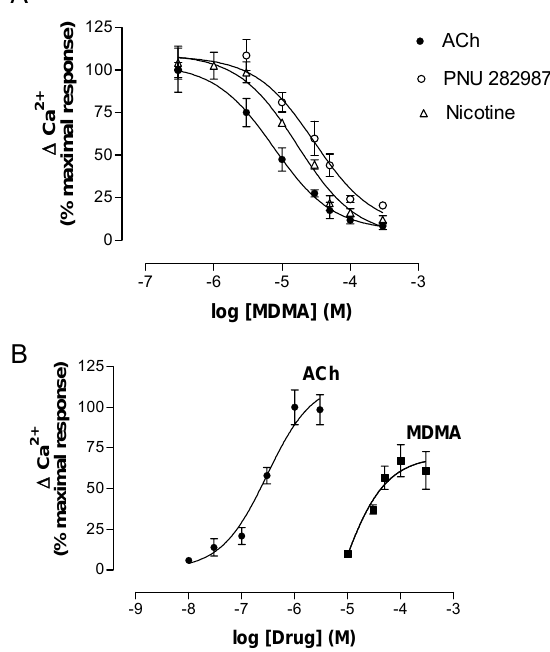
Figure 8. ( A ) Effect of increasing concentrations of MDMA on the responses to the nicotinic agonists ACh (100 µM), nicotine (100 µM) and PNU 282987 (0.1 µM) in PC12 cells loaded with Fluo-4. MDMA was added to the cells 5 min before the agonist. Basal fluorescence levels were measured for 5 s before the agonist and for a further 60 s after its addition by means of an automated injector. ( B ) Representative concentration-response curves showing the increase in cytosolic Ca 2+ induced by MDMA and ACh as a total agonist. Responses were normalized as % (Fmax-Fmin) and represented as a percentage of the maximum response (ACh 100 µM) for both